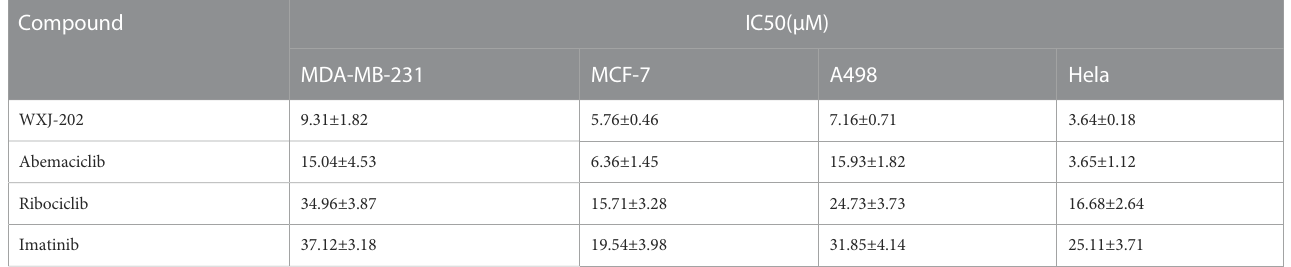
TABLE 1 The cytotoxic effects of compound WXJ-202 and positive drugs (abemaciclib, ribociclib, and imatinib) on MDA-MB-231, MCF-7, A498, and Hela cell lines. Compound